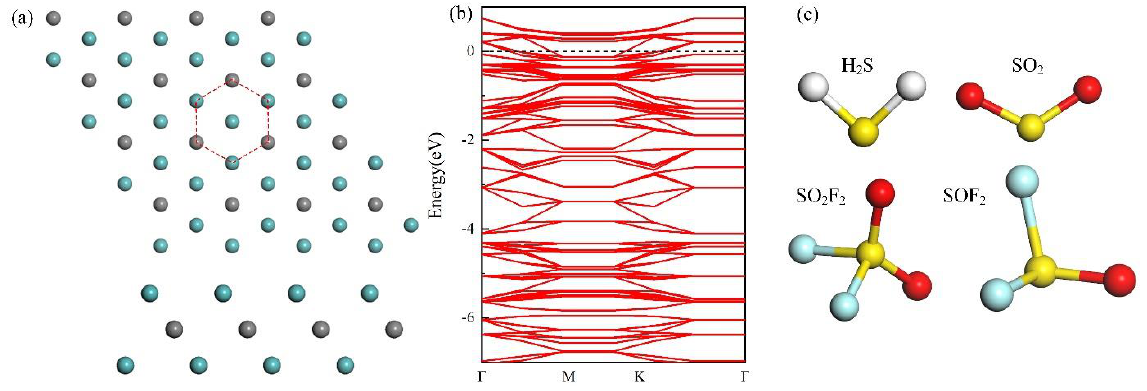
Figure 1. ( a ) most stable conformation, ( b ) band structure of Mo 2 C and ( c ) four molecular models. Table 1. Adsorption energy (E ad ), adsorption distance (D), and transferred charge (Q) for the best adsorption configuration of four gas molecules on Mo 2 C. D (Å ) is the distance between the gas mol- ecule and the nearest atom of the adsorption substrate; Q (e) is the charge transfer between the gas molecule and the adsorption substrate.